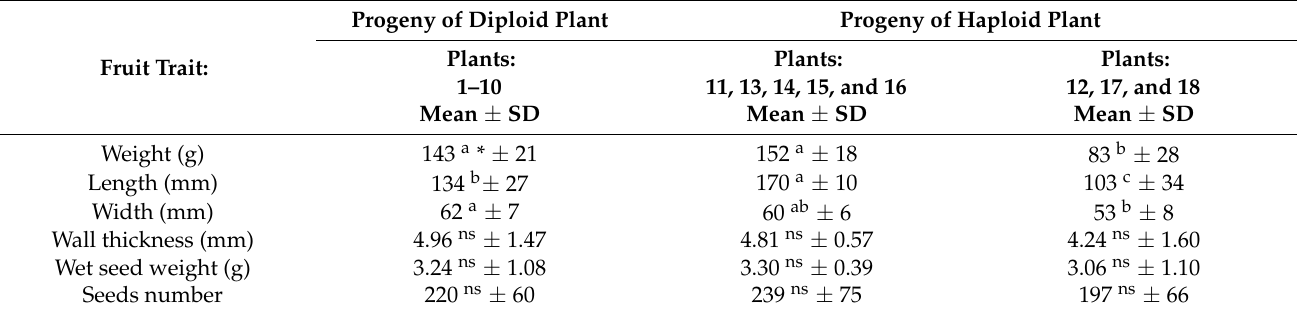
Figure 3. DNA content in cells of two anther-derived plants of ( C. annuum L. ATZ × C. annuum L. Corno di toro)F 2 : haploid (1C DNA) histogram and fruits on the left and diploid (2C DNA) histogram and fruits on the right. Table 1. Variation of fruit traits of the sexual progeny of diploid (plants 1–10) and apomictic progeny of haploid (plants 11–18) C. annuum